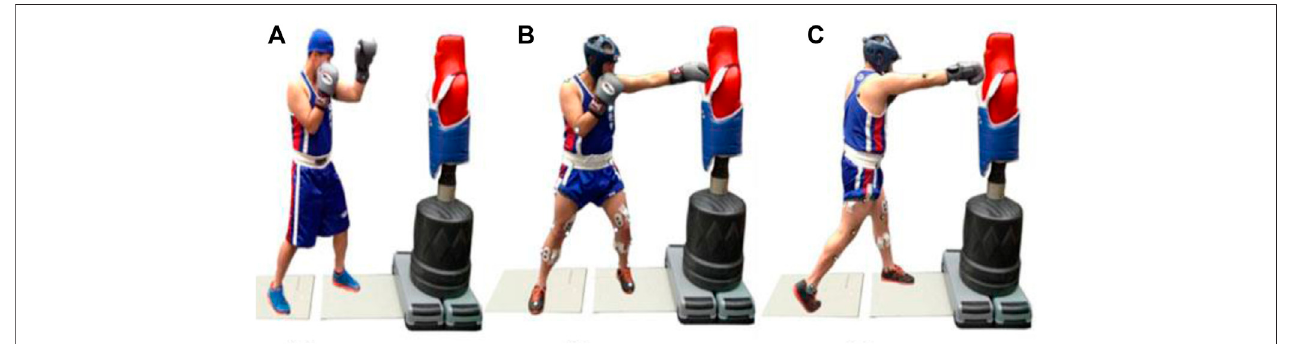
FIGURE 1 | Punching assessment, (A) start to landing; (B) landing to jab; (C) jab to